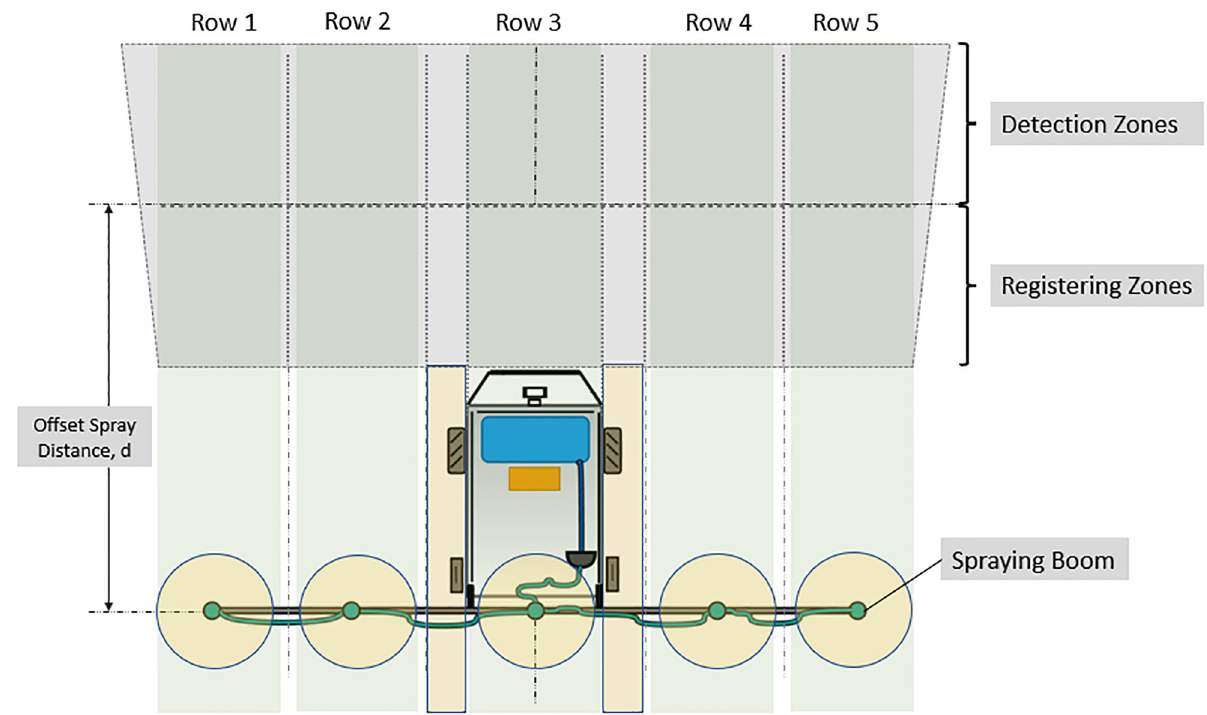
Fig 4. Robot camera field of view with spraying zones